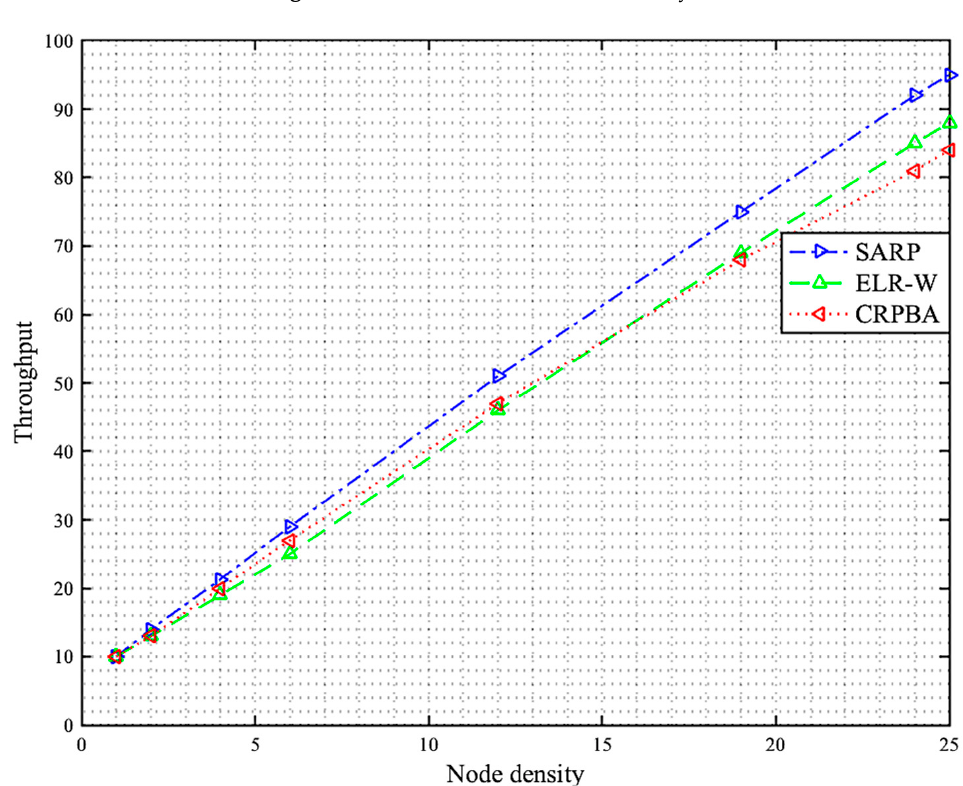
Figure 5. Throughput vs node density.